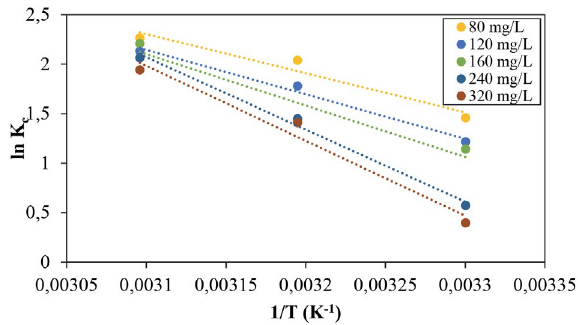
Fig. 13. Influence of ionic strength on